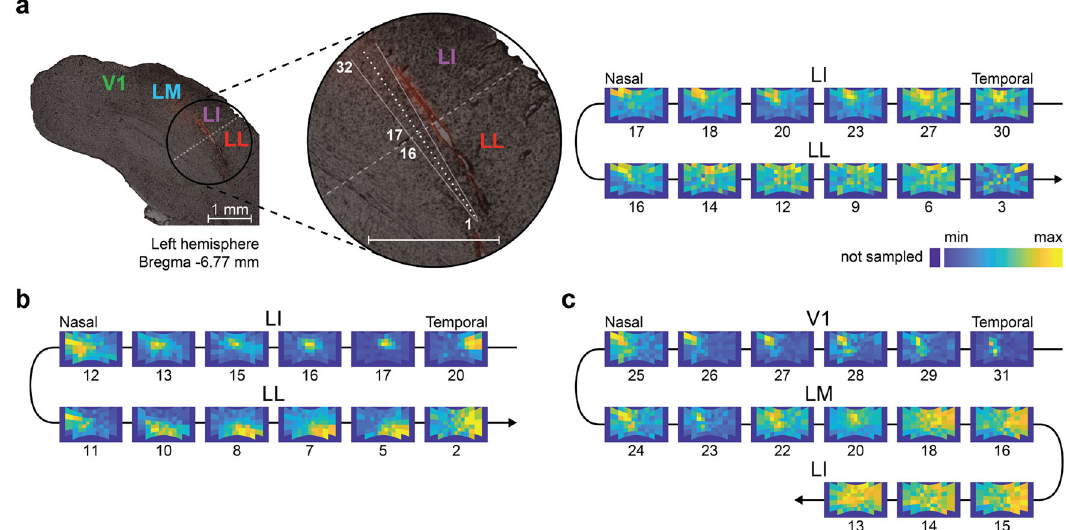
Fig. 2 Functional identi fi cation of rat visual cortical areas. a Left: overlay of a fl uorescence image on a bright- fi eld image of a coronal slice of rat visual cortex, from which neuronal recordings were obtained using a single-shank silicon probe with 32 recording sites, spanning 1550 μ m. Before being inserted obliquely into cortex (to target lateral extrastriate areas LI and LL), the probe was coated with a red fl uorescent dye that allowed reconstructing its insertion track (red stain). The close-up view shows the geometry of the probe (white lines) alongside the insertion track and the relative positions of the recording sites (white dots), from the tip (site # 1) to the base (site # 32) of the probe. Right: fi ring intensity maps showing the RFs of the units recorded at selected recording sites along the probe (indicated by the numbers under the RF maps). The reversal in the progression of the retinotopy between sites 16 and 17 marks the boundary between areas LI and LL (shown by a dashed line on the left panel). b , c Retinotopic progressions of the RFs recorded in two other example sessions. One session featured a single reversal between LL and LI within a span of the recording sites of 1550 μ m ( b ). The other session featured two reversals, one between V1 and LM and another one between LM and LI, which were made possible by the larger depth spanned by the probe (3100 μ